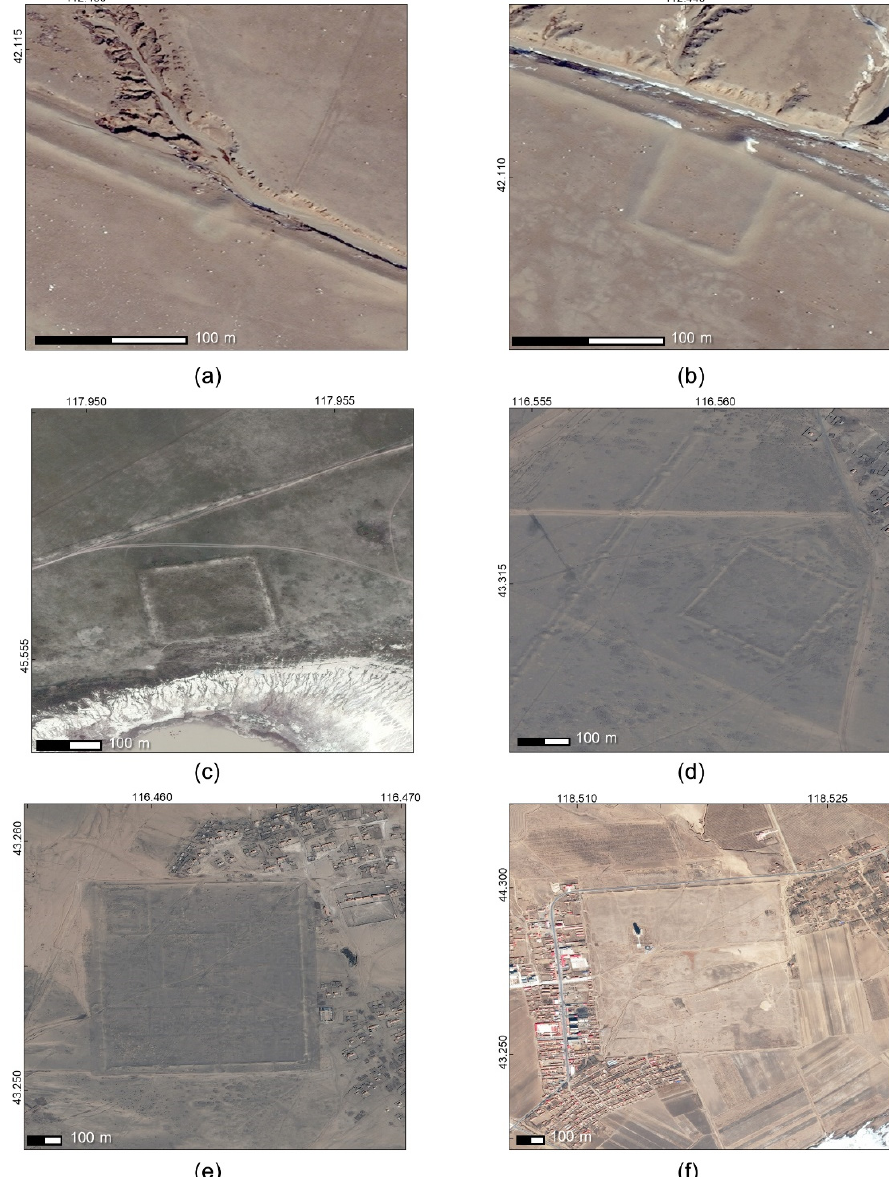
Figure 5. The different size classes as defined by Xie (2020): ( a ) Class 1, very small; ( b ) Class 1, normal fort size; ( c ) Class 2; ( d ) Class 3; ( e ) Class 5, a walled city; ( f ) Class 6, a walled city.